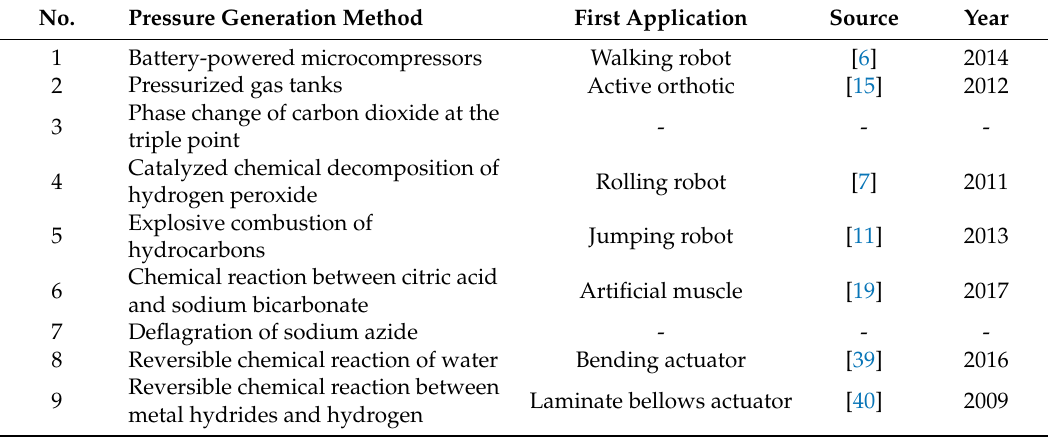
Table 7. Pressure generation methods and corresponding first applications in soft robotics.